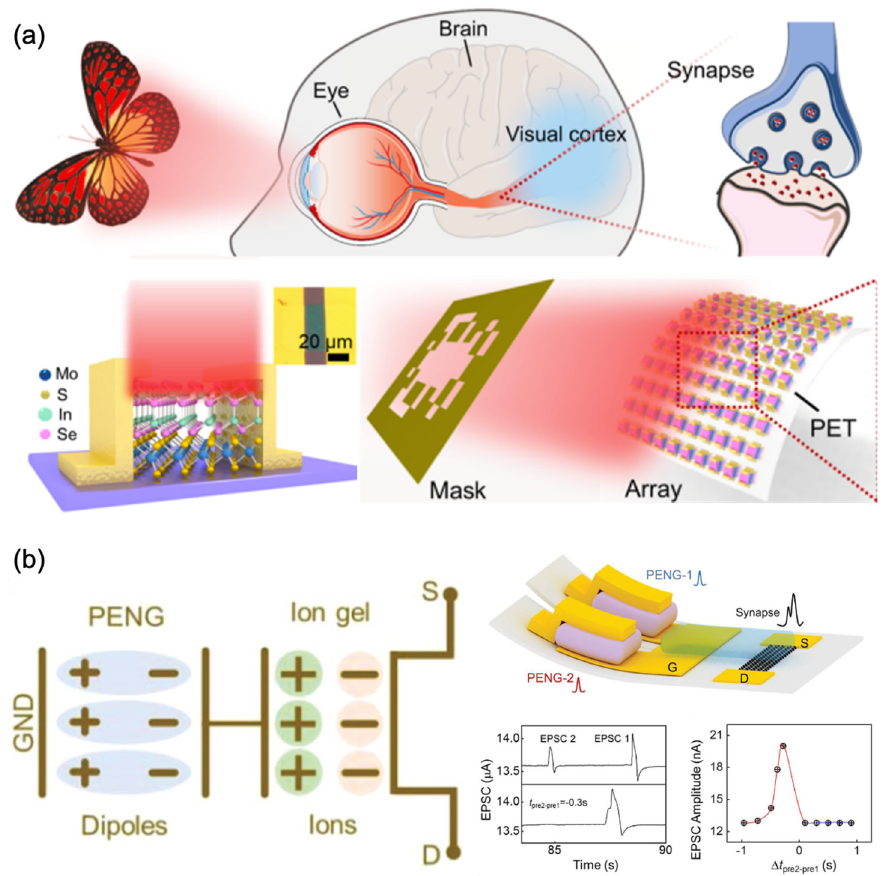
Figure 13. ( a ) Schematic diagrams for the biological visual system and the In 2 Se 3 /MoS 2 synaptic device and the demonstration of imaging functions of the In 2 Se 3 /MoS 2 synaptic device array [144] Reprinted/adapted with permission from Ref. [144] Hu, 2022. ( b ) Equivalent schematic diagram of the coupling effect of piezoelectric potential through an ion gel; the schematic illustration of the piezotronic graphene artificial sensory synapse with two artificial presynaptic sensor neurons (PENG-1 and PENG-2) and the EPSC response under various stimuli [146] Reprinted/adapted with permission from Ref. [146] Chen,